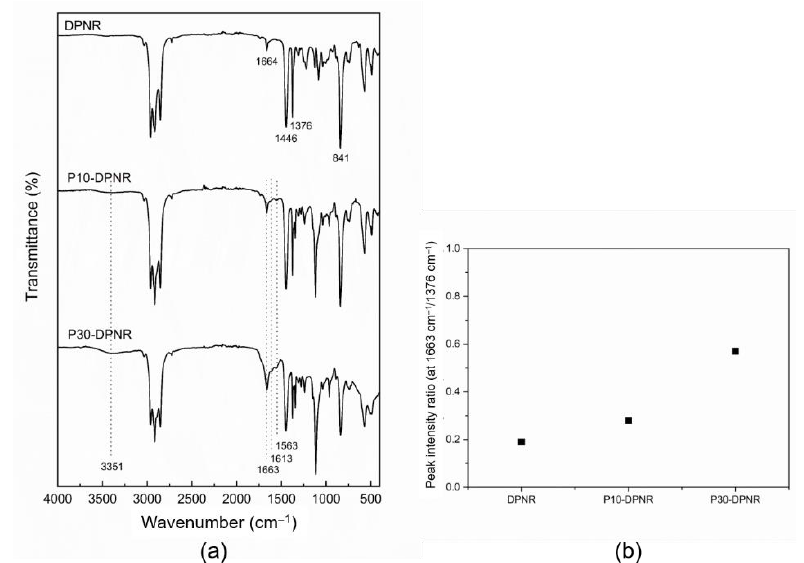
Figure 4. ( a ) FTIR spectra of the (PAA- co -PAM)-DPNR prepared by using 10 and 30 phr monomer content after extraction; ( b ) the relationship of peak intensity ratio at 1663 cm − 1 /1376 cm − 1 of the prepared (PAA- co -PAM)-DPNR compared to the DPNR (1664 cm − 1 /1376 cm − 1 ).